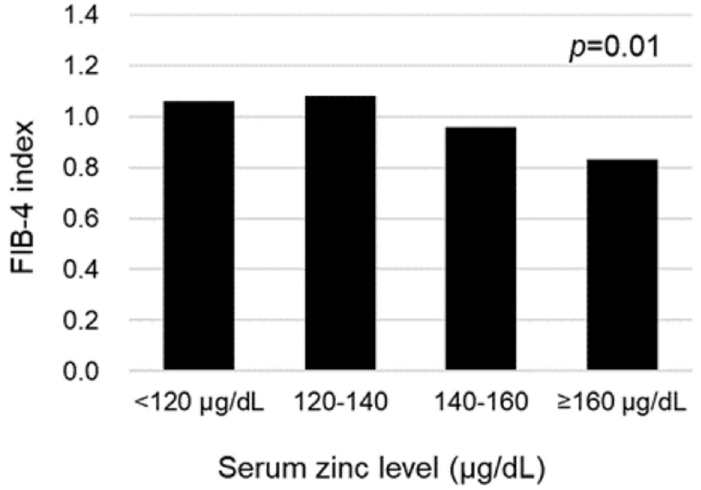
Fig 3. Hepatic fibrosis (FIB-4 index) according to serum zinc level in NAFLD. Abbreviations: NAFLD, nonalcoholic fatty liver disease; FIB-4, fibrosis-4.